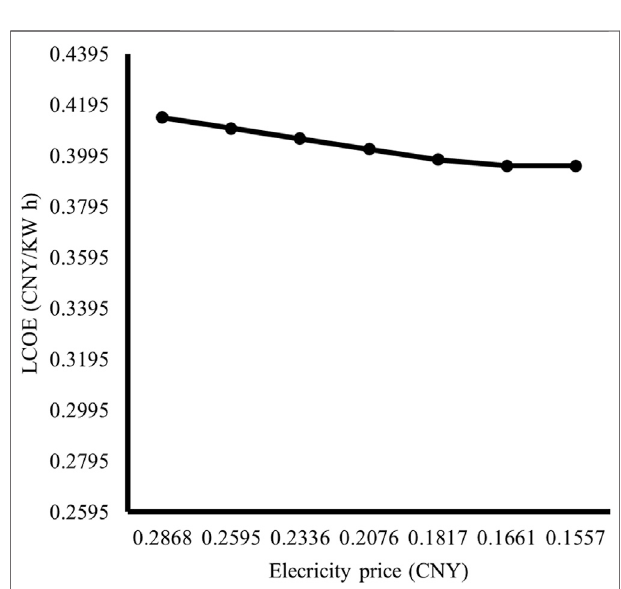
FIGURE 9 | LCOE of the Pingluo project when the electricity price is gradually